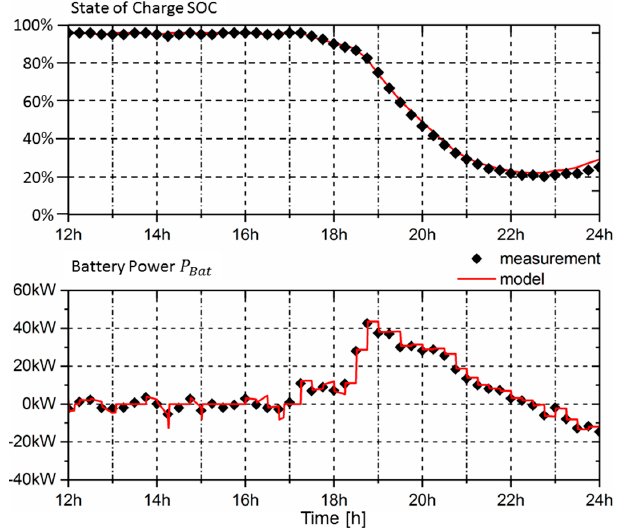
Figure 22. SOC and power P Bat during charging.